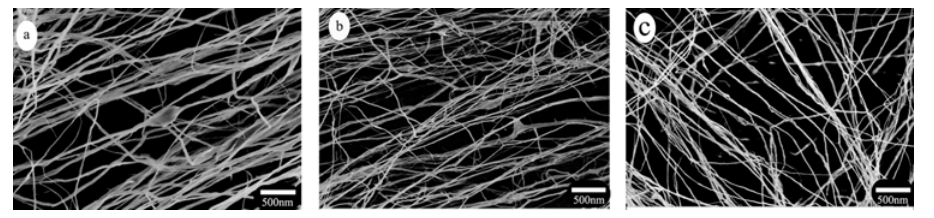
Fig 4. FE-SEM images of (a) CNF-1, (b) CNF-2, and (c) CNF-3.